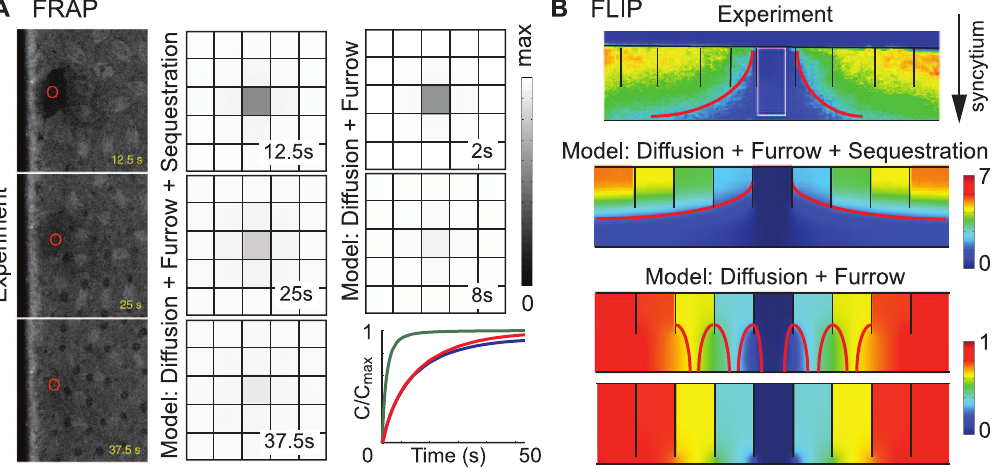
Figure 4. Restricted diffusion of Dorsal in the syncytial embryo. For the sake of computational efficiency on the much larger spatial domain, the simulation was carried out using field equations that depict the density profile of the Dorsal protein, instead of agent-based method that traces each protein particles (see Methods). The field equations were defined on a rectangular block of dimensions 35 m m W 6 35 m m D 6 14 m m H. The top area of 7 m m in height are divided into 5 6 5 cubic subdomains with impermeable vertical boundaries between each other. These subdomains represent the nuclei-associated energids in the syncytial embryo cortex. There are no boundaries between each subdomain and the rest of the space. (A) Comparison with FRAP experiment, top view (also see Movie S5, S6). Left column: experiment data. Middle column: computational result with microtubule-mediated sequestration and furrows. Top two panels in the right column: computational result with pure diffusion restricted by furrows only. The gray scale bar shows the normalized concentration with respect to the maximum concentration at time 0 in the computational results. Bottom panel in the right column: temporal curves of Dorsal concentration at the central point of the photobleached domain, with sequestration (blue), with pure diffusion at D =20 m m 2 /s (green), or with pure diffusion at D =3 m m 2 /s (red). The sequestered case thus demonstrates a phenomenological diffusion coefficient of , 3 m m 2 /s. (B) Comparison with FLIP experiment, side view (also see Movie S7, S8, S9). Top: experiment data at t=108 s. Middle: computed concentration profile with microtubule-mediated sequestration and furrows at t=108 s. Bottom: computed concentration profile with pure diffusion restricted by furrows only at t=108 s, with the gap width between neighboring energids of 7 m m (upper) or 1 m m (lower). The black lines mark the membrane boundaries between neighboring energids. The white box shows the area of photobleaching. The red lines show the characteristic shape of the contour lines of the concentration profiles. The color bar shows the relative Dorsal concentration. In both the FRAP and FLIP simulations, the effective binding rate k on =5 s 2 1 ( , microtubule density of 3 m m 2 2 , or 150 microtubules within each energid, cf. Figure S1), the unbinding rate k off =1 s 2 1 . The diffusion coefficient of unbound protein D =20 m m 2 /s except for the red temporal curve in (A) (cf. [26], the cytoplasmic diffusion coefficient of GFP is 25 m m 2 /s and the molecular weight of Dorsal ( , 90 kD, [27]) is about 3 times that of GFP ( , 30 kD, [28])). The experimental data are adapted from Delotto et al , 2007 [13].